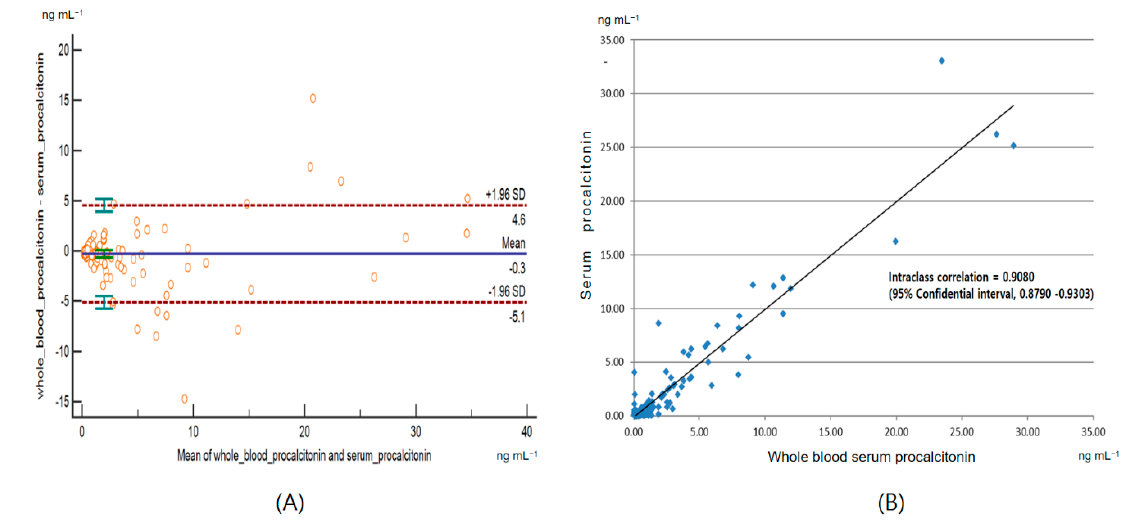
Figure 2. Bland–Altman plot ( A ) and intraclass correlation ( B ) between serum procalcitonin and whole blood procalcitonin.